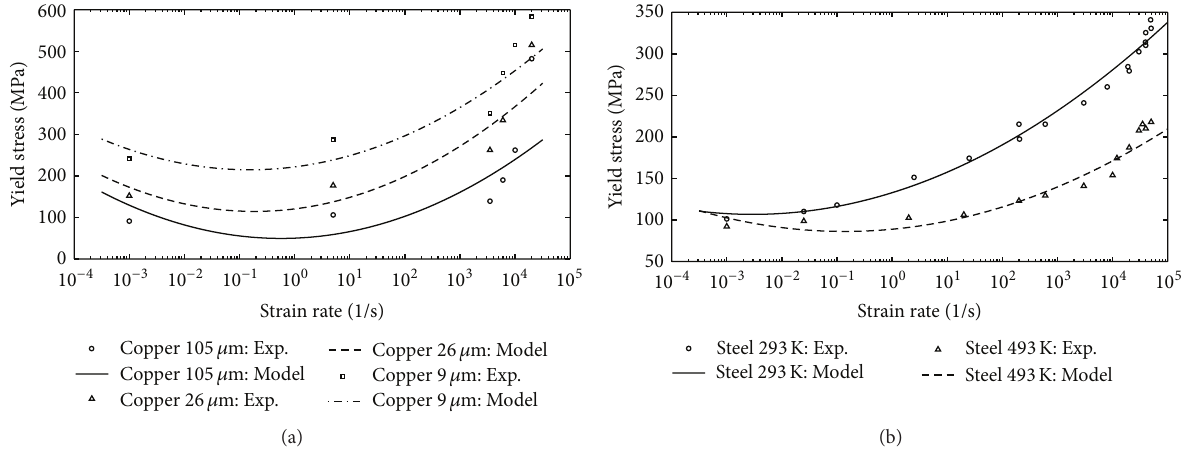
Figure 2: Yield stress fitting by the Huh-Kang model: (a) copper and (b) steel.